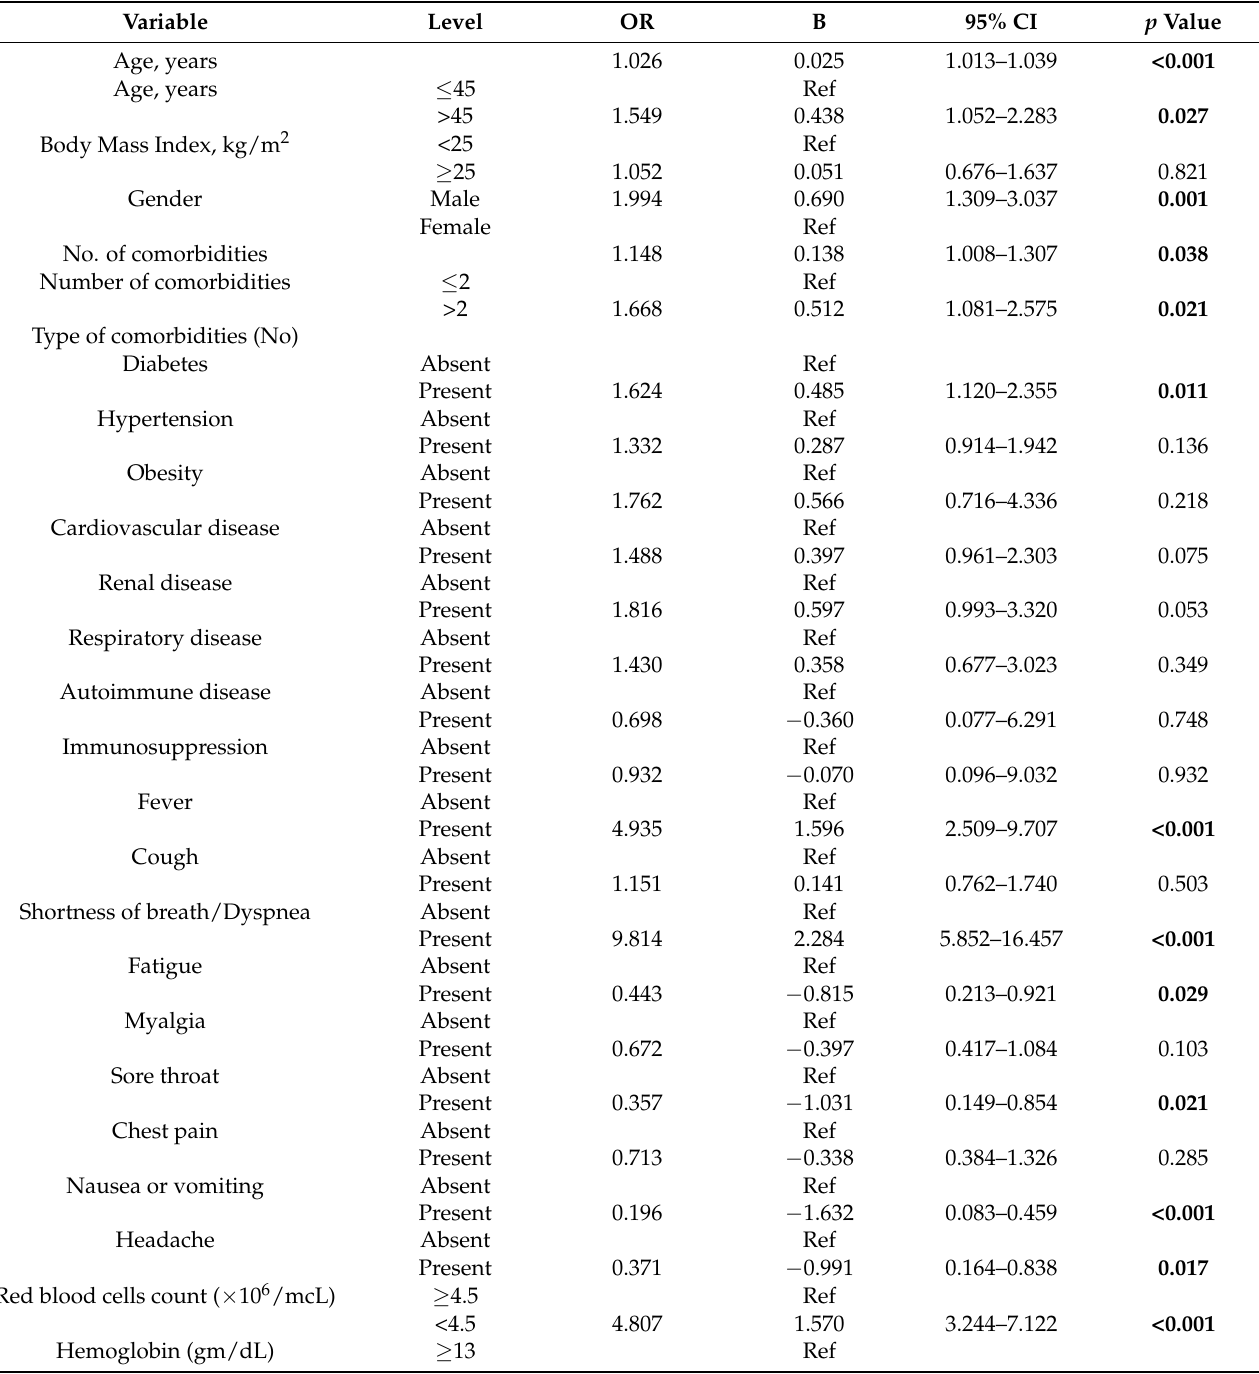
Table 3. Univariable logistic regression model of risk factors for severity of